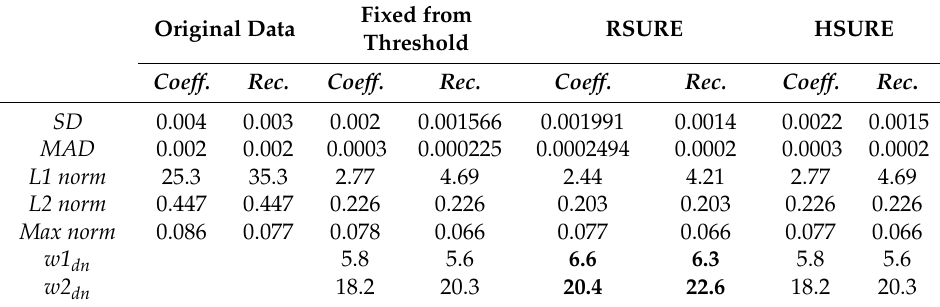
Table 4. Statistics for the coefficients and reconstruction of the original and denoised signal for a power line (data set II).